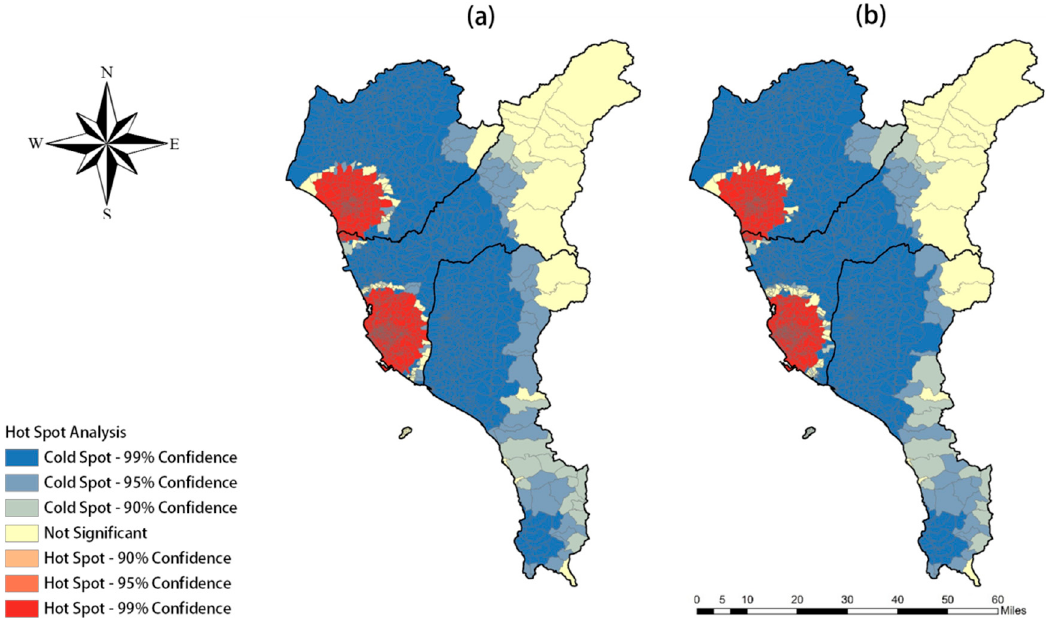
Figure 3. The results of hot spot analysis: ( a ) number of dengue cases; ( b ) dengue fever incidence.